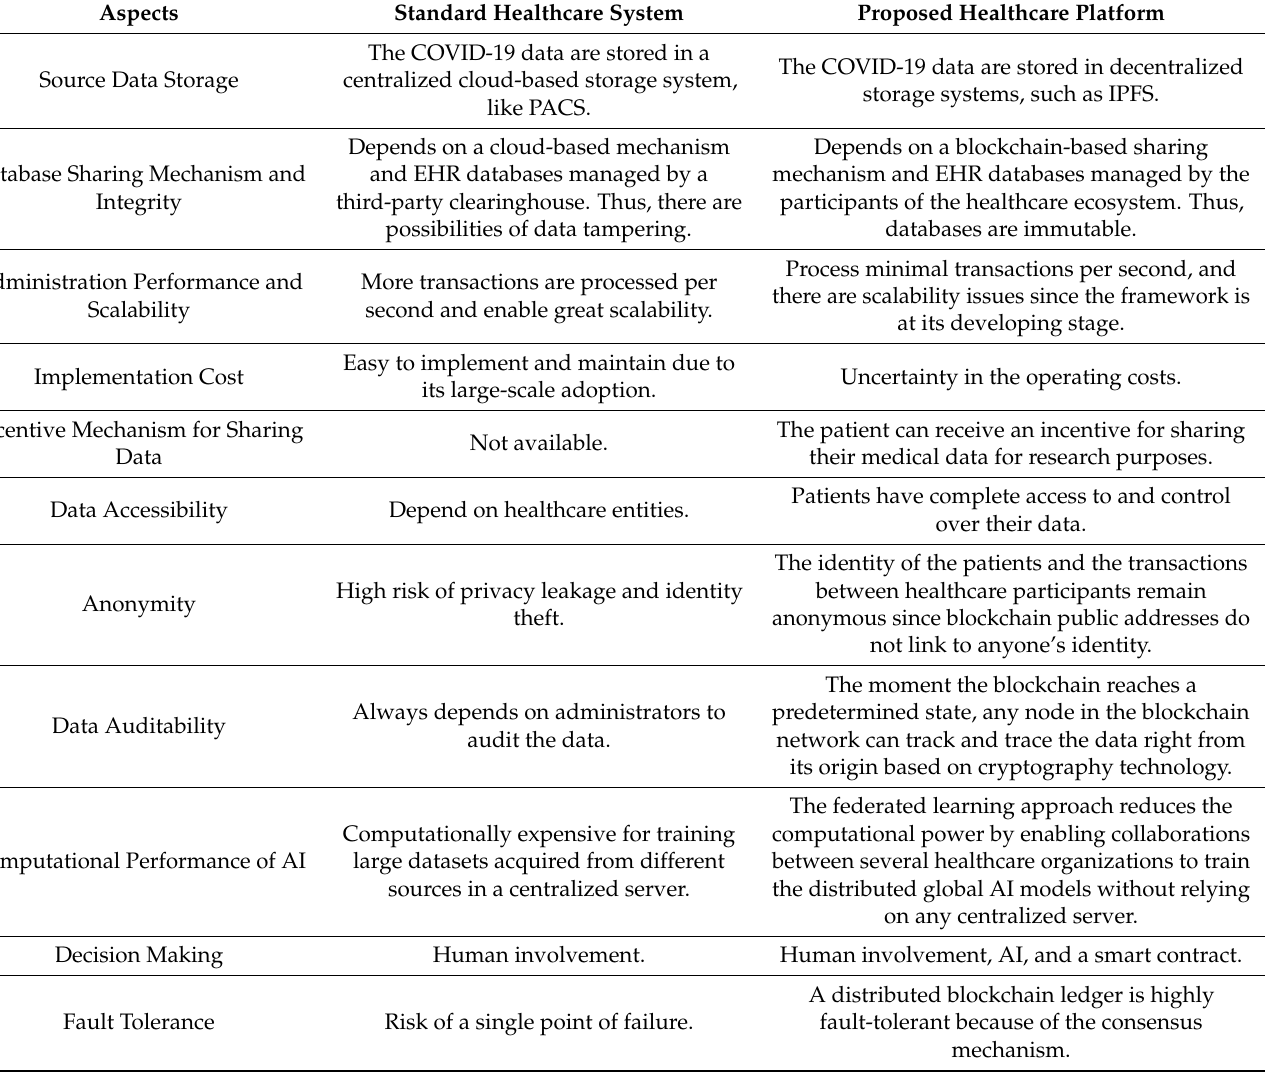
Table 2. Comparison between traditional healthcare systems over proposed healthcare system based on various technical aspects and their